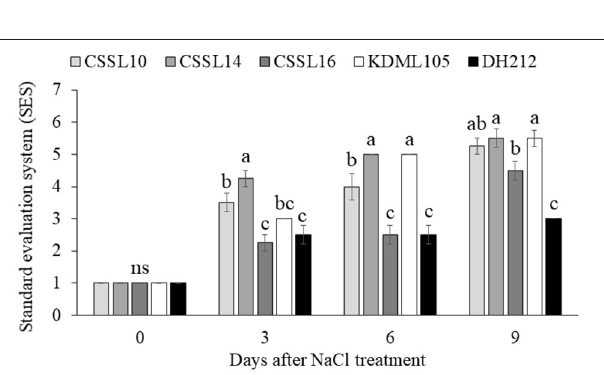
FIGURE 5 | Standard evaluation system (SES) determined from the appearance of plants under salt stress condition for 0, 3, 6, and 9 days. Values are presented as mean ± SE ( n = 4). Different letters above bars indicate significant difference between lines at p < 0.05. “ns” indicates no significant